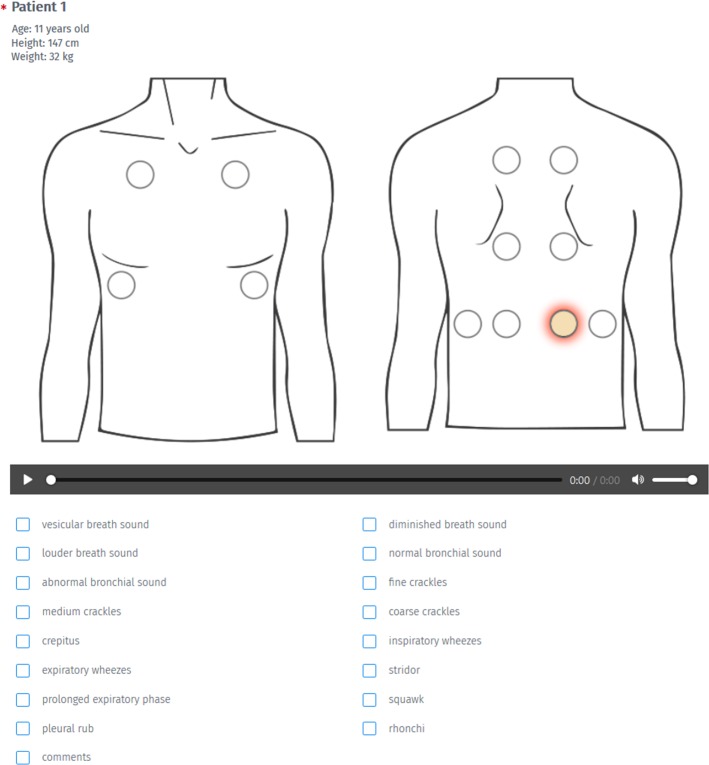
An example of the answer sheet used in the experiment and possible answers.During the experiment more than one class could be marked and each sound could be played as many times as needed.